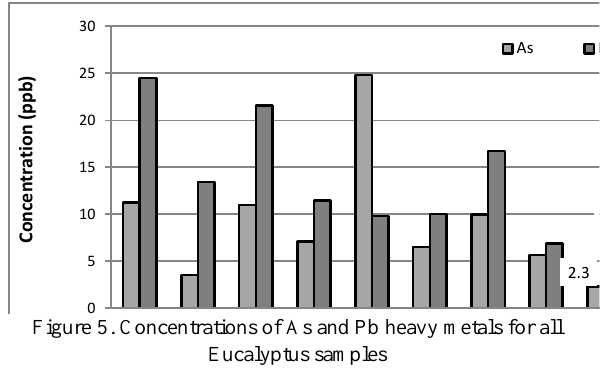
Figure 5. Concentrations of As and Pb heavy metals for all Eucalyptus samples